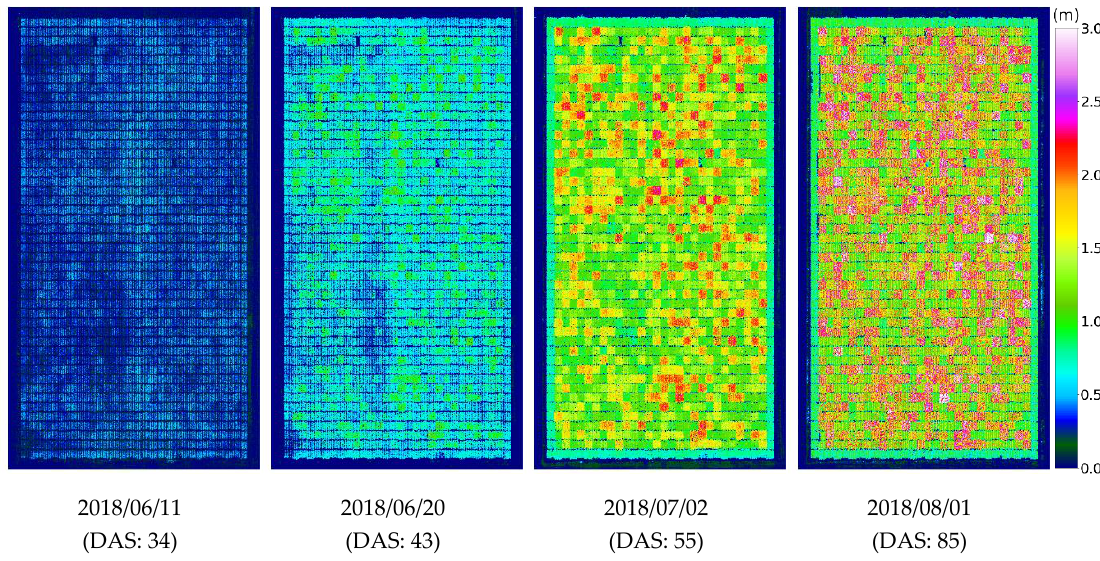
Figure 7. The 8 cm resolution DSM for multiple dates in the 2018 growing season for the SbDivTc